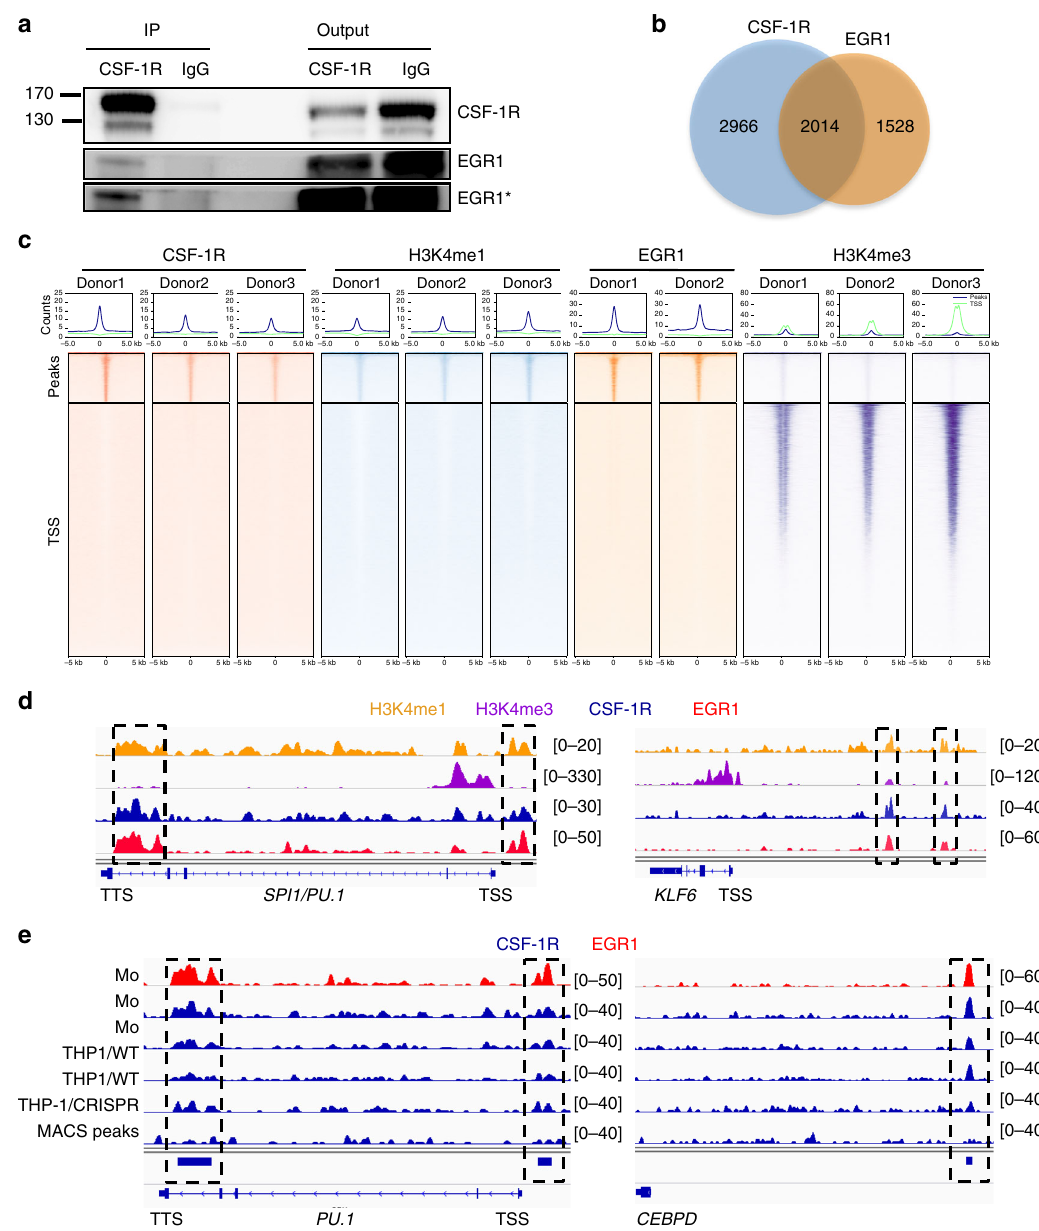
Fig. 4 CSF-1R interacts with EGR1 to modulate gene expression. a Co-immunoprecipitation experiment using an anti-CSF-1R (sc-365719) or a control IgG in monocytes followed by immunoblotting with anti-CSF-1R and anti-EGR1 antibodies ( n = 3). Asterisk (*) indicates a longer exposure of the blot. b Venn diagram of peak calling (input normalization) common to three donors from ChIP-seq experiment with sc-46662 anti-CSF-1R and sc-110X anti-EGR1 antibodies. c Ranking heatmap centered on CSF-1R peaks (top) and on gene transcription starting sites (TSS) of CSF-1R, H3K4me1, EGR1 and H3K4me3 peaks in monocytes. d Peak calling for H3K4me1 (orange), H3K4me3 (purple), EGR1 (red), CSF-1R (blue). ChIP-seq on PU.1 and KLF6 genes in monocytes (TSS: transcription starting site, TTS: transcription termination site). e Peak calling on PU.1 and CEBPD genes for EGR1 in monocytes and for CSF-1R in monocytes (Mo) from two donors (in blue, same donors as in Fig. 3), wild-type THP-1 clones (THP1/WT), THP-1 clones deleted for EGR1 (pool of 3 clones, THP1/CRISPR) indicated that CSF-1R was less recruited to intergenic regions 21.2% of monocyte and macrophage peaks, respectively, Supple- (26.4%) as compared with untreated monocytes (63.5%, Fig. 3b) mentary Data 7). ChIP-Seq experiments with histone marks while a signi fi cant fraction of CSF-1R was detected on promoter- H3K4me1 and H3K4me3 performed on the same samples TSS (transcription starting site) (11.9%), exonic (9.1%) and 5 ′ showed a higher fraction of CSF-1R associated with H3K4me1 UTR (9.9%) regions (Supplementary Fig. 5b). CSF-1R promoter- in monocytes and H3K4me3 in macrophages (Fig. 7a and TSS recruitment was validated by ChIP-qPCR for CFMS, MYB, Supplementary Data 8 – 11, respectively). Ranking heatmaps EZH2, FOS, YY1 and IL6R genes in macrophages from centered on TSS indicated that CSF-1R is relocalized around independent healthy donors, RAC2 being used as a negative the TSS where it colocalizes with H3K4me3 in macrophages control (Supplementary Fig. 5c). (Fig. 7b), as exampli fi ed for MAFB, JUN, and MYC genes Comparison of peak localization in monocytes and macro- (Supplementary Fig. 5d). CSF-1R location also changed from the phages identi fi ed 1192 common peaks (representing 23.9% and promoter region of PU.1 gene in monocytes to PU.1 fi rst intron in NATURE COMMUNICATIONS| (2019) 10:1935